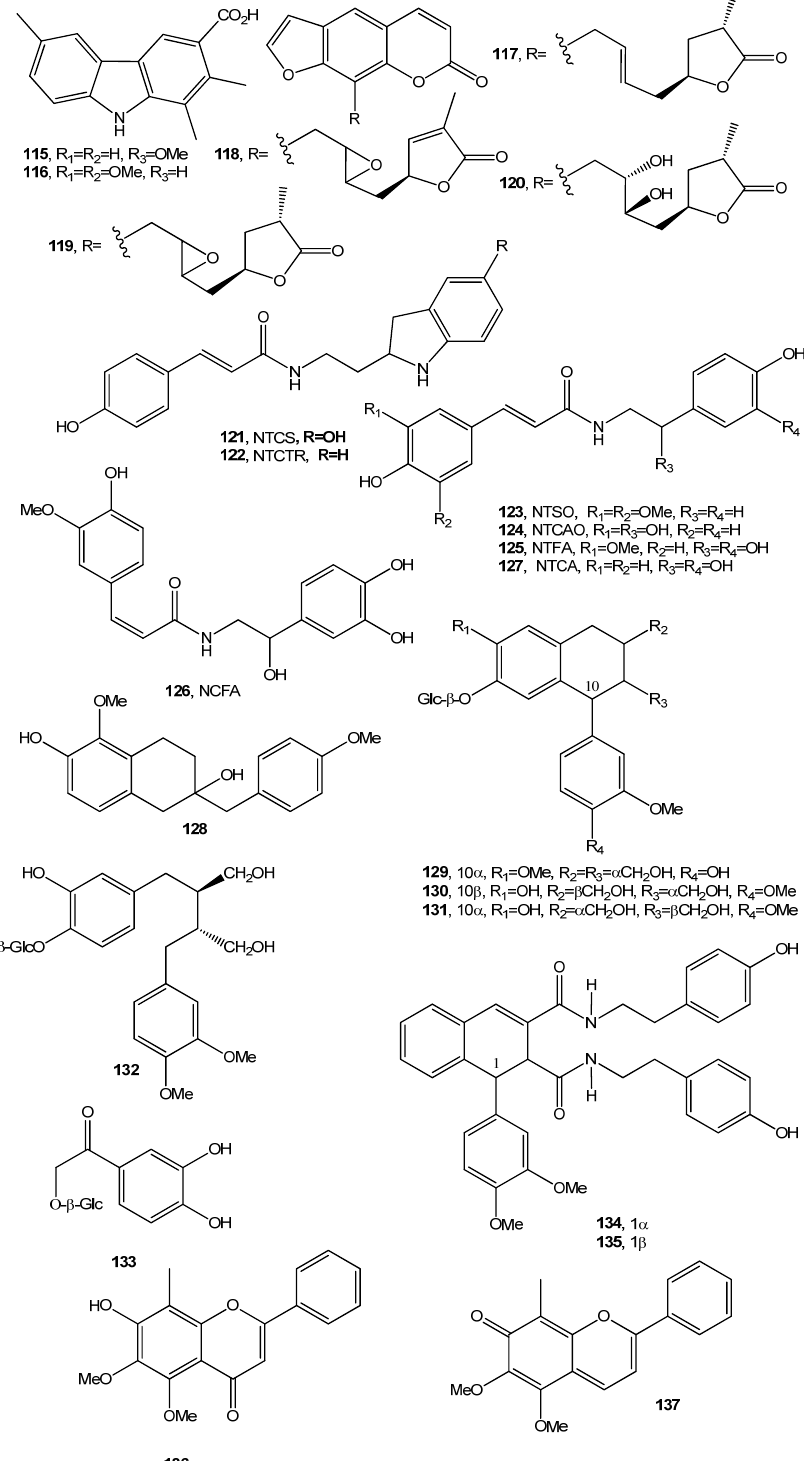
Figure 9. The structures of compounds 115 – 137